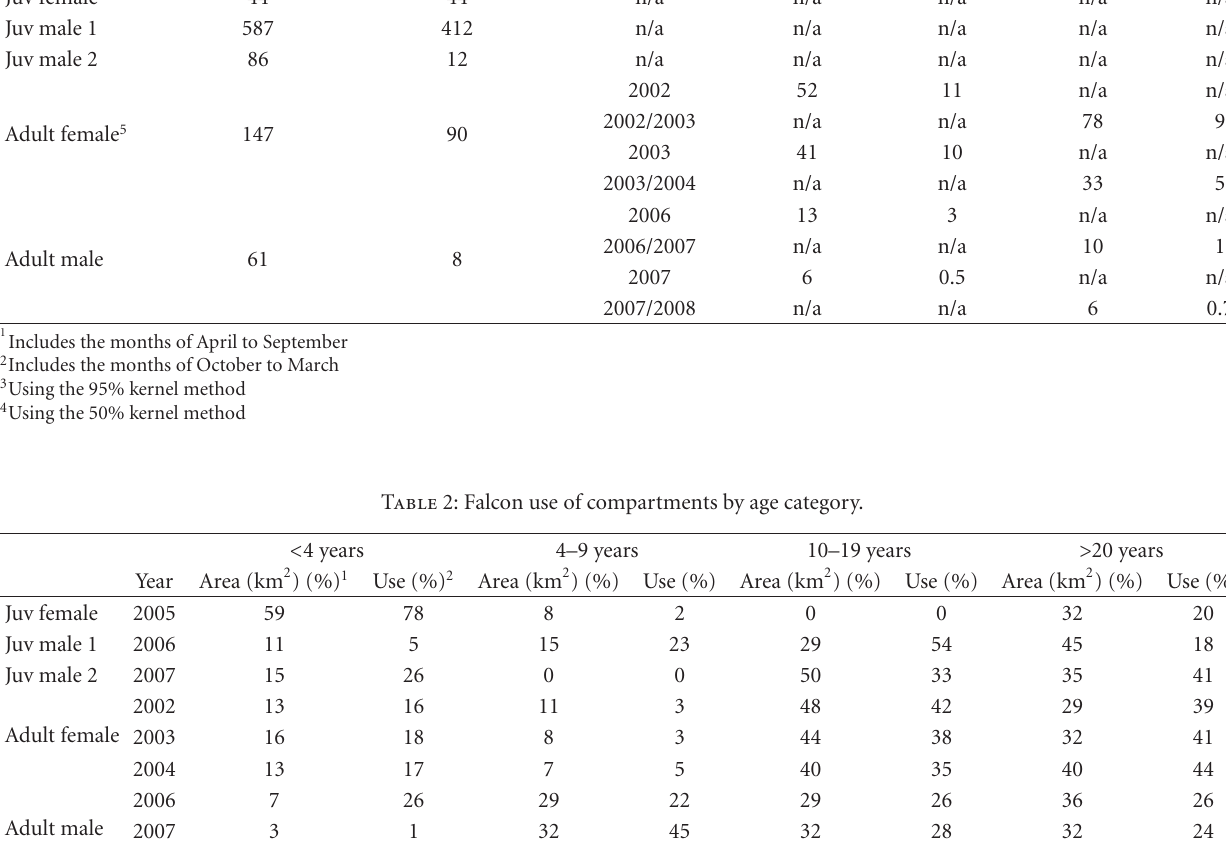
juveniles dispersed from their natal territory was 68 days for the juvenile female and 69 and 58 days for juvenile male 1 and 2,